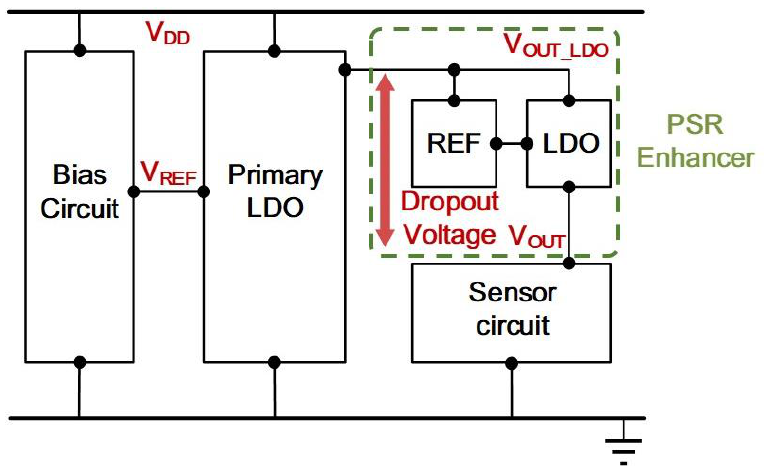
Figure 2. A Sensor Circuit Powered by a LDO Regulator with a PSR Enhancer.